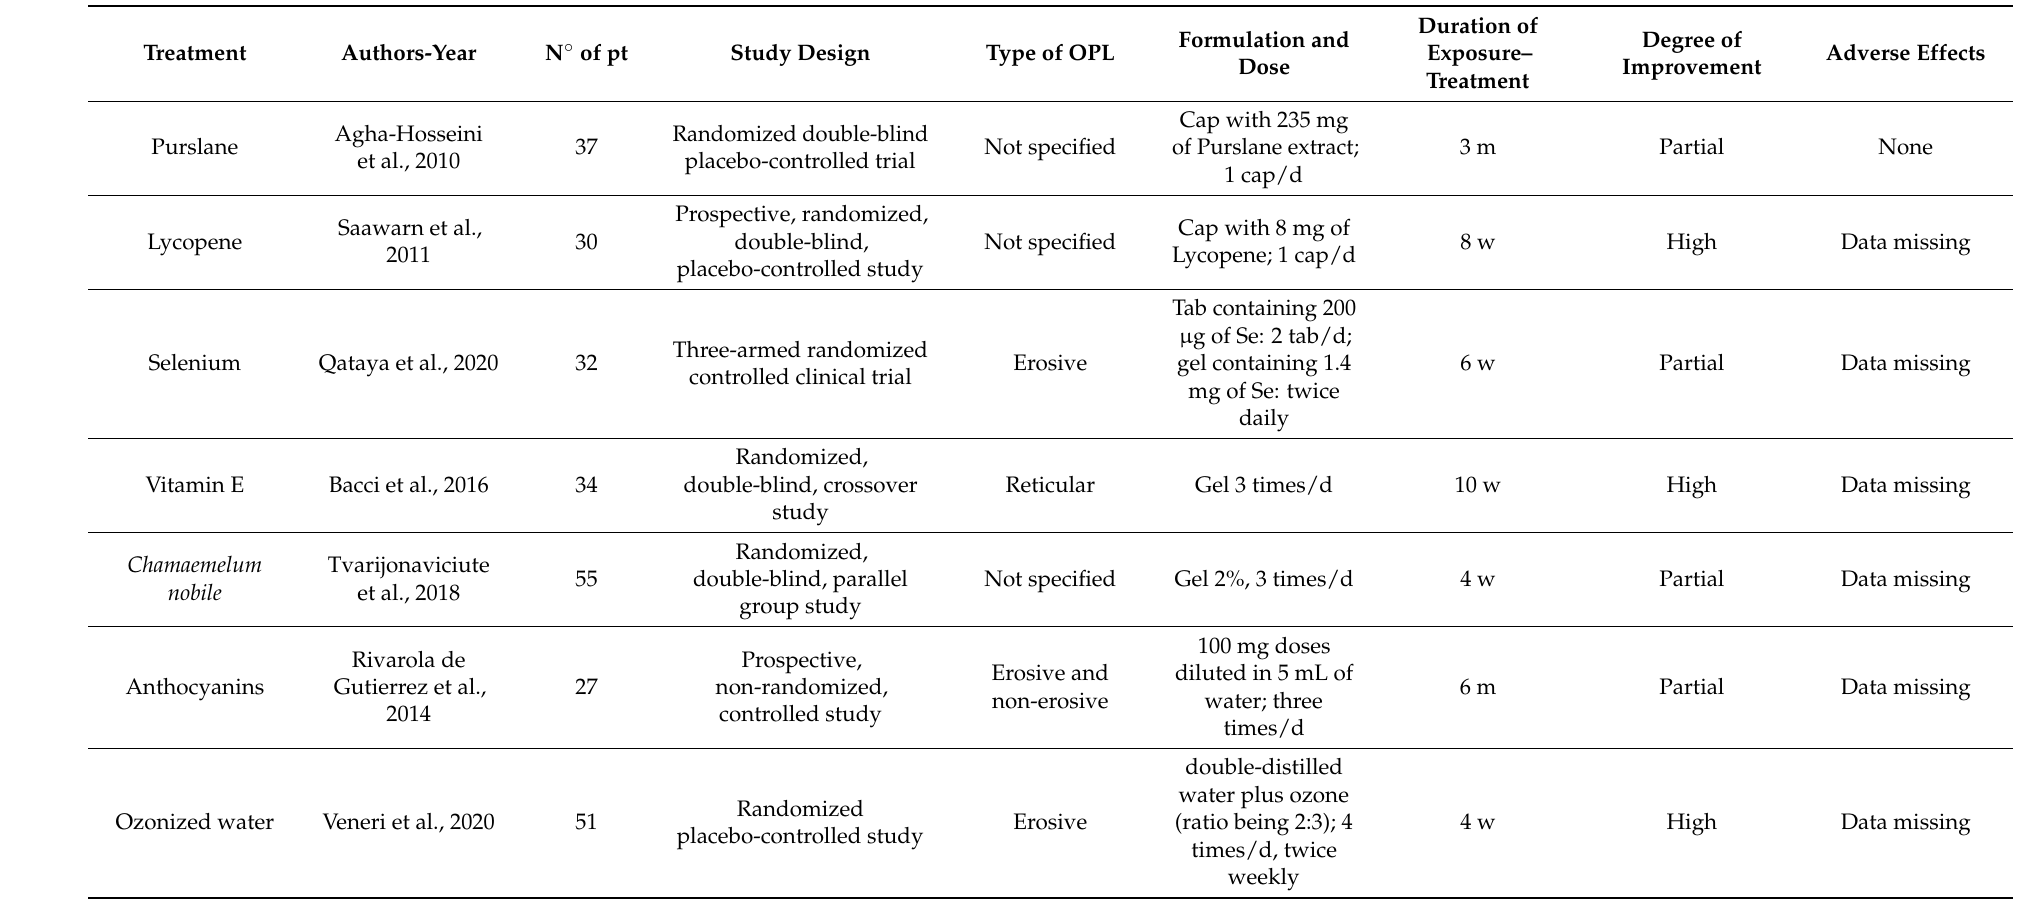
Table 3. Summary of studies on the efficacy of treatments with antioxidant potential in lichen